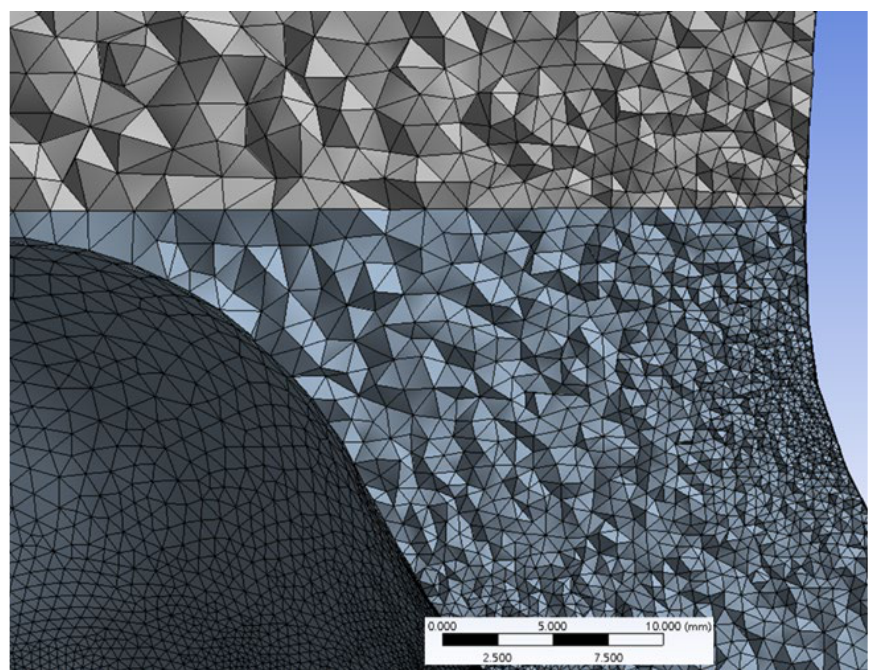
Figure 6. Joint of inlet tube and impeller of mesh. (Stage 1).